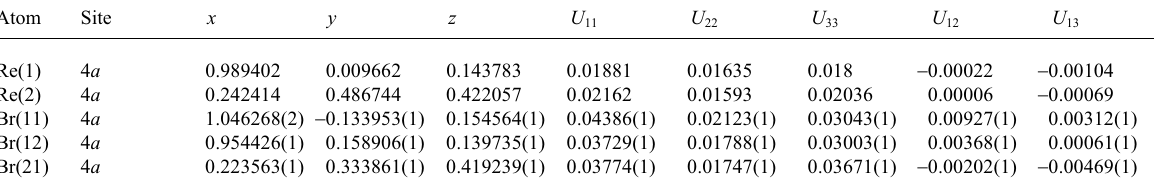
Table 3. Atomic coordinates and displacement parameters (in Å 2 )